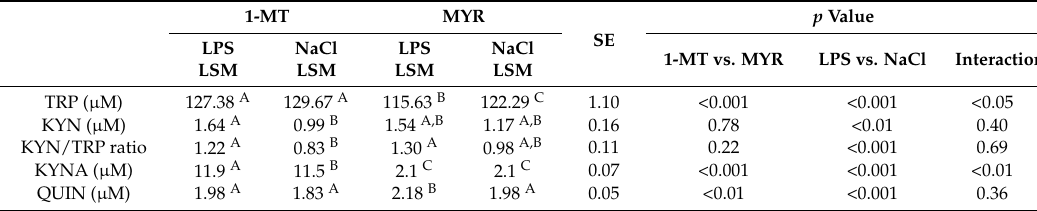
Table 1. Pairwise comparisons of the pre-treatment 1-MT vs. MYR and the treatment LPS vs. NaCl in plasma using a Tukey–Kramer test. p Value 1-MT MYR SE LPS NaCl LPS NaCl 1-MT vs. MYR LPS vs. NaCl Interaction LSM LSM LSM LSM TRP ( µ